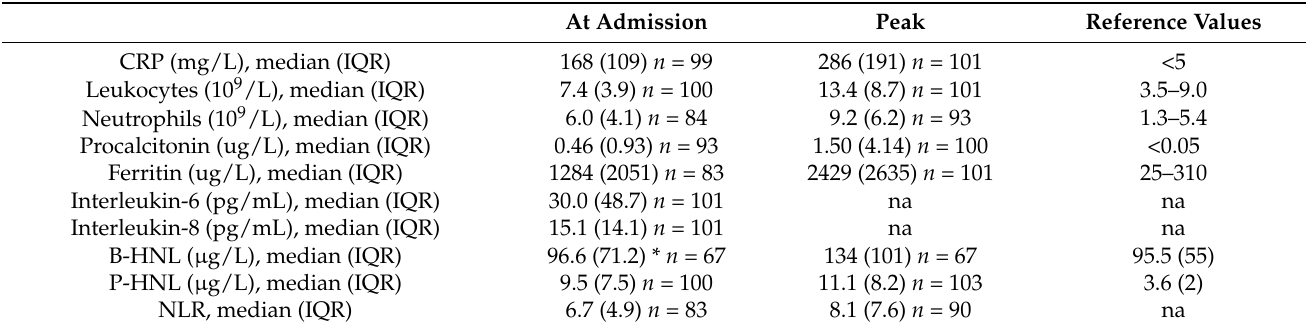
Table 2. Routine chemistry and inflammatory markers.